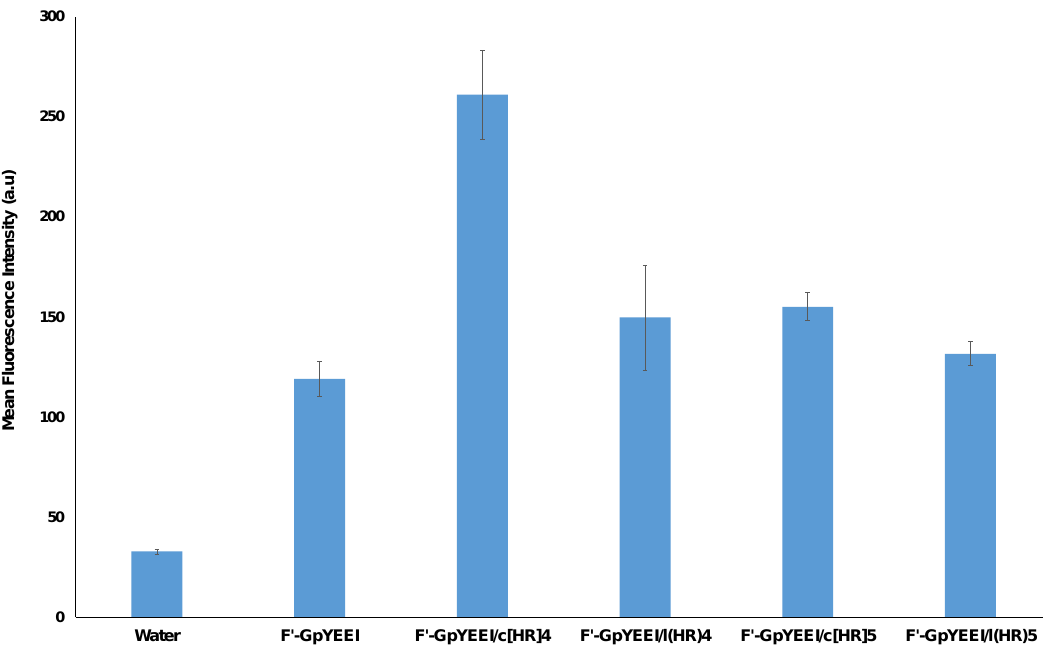
Figure 4. Cellular uptake study of F’-GpYEEI phosphopeptide at 5 µM by c[HR] 4 , c[HR] 5 , l(HR) 4 , and l(HR) 5 at 50 µM peptide concentration in SK-OV-3 cancer cell lines.